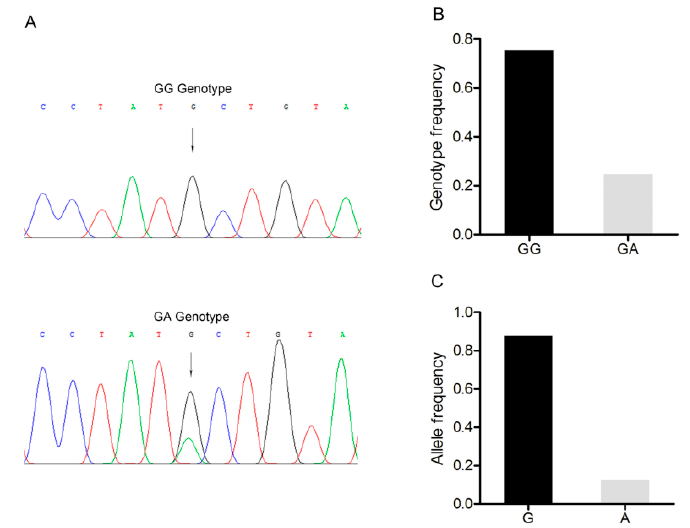
Figure 4. Mutation c.2366G > A in the 3’-untranslated region of the Large White pig BMP15 gene. ( A ) Sequence of di ff erent genotypes at the mutation c.2366G > A. The arrow indicates the substitution position. ( B ) Genotype frequency of the mutation c.2366G > A. ( C ) Allele frequency of the mutation c.2366G > A. n = 227.